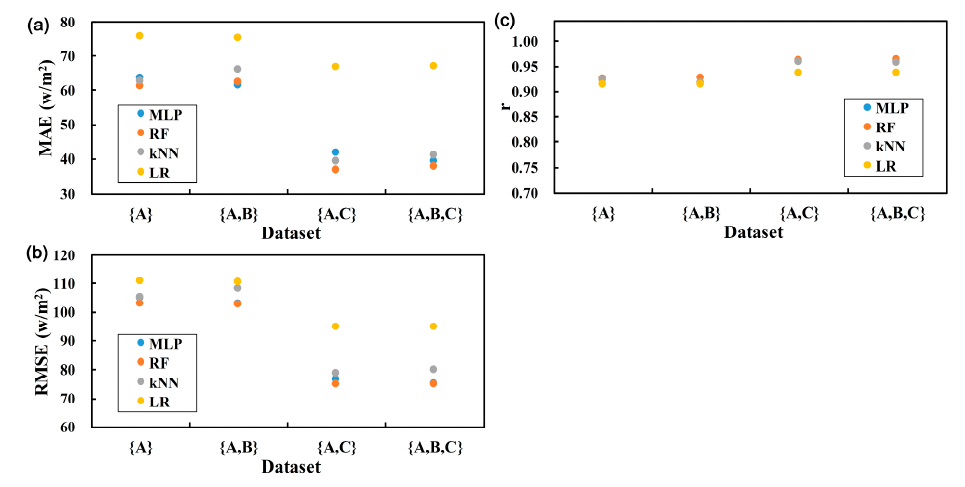
Figure 5. Performance of dataset combinations for solar irradiance at t + 1: ( a ) MAE, ( b ) RMSE, and ( c ) r. Table 3. Average performance of dataset combinations for solar irradiance at t + 1.